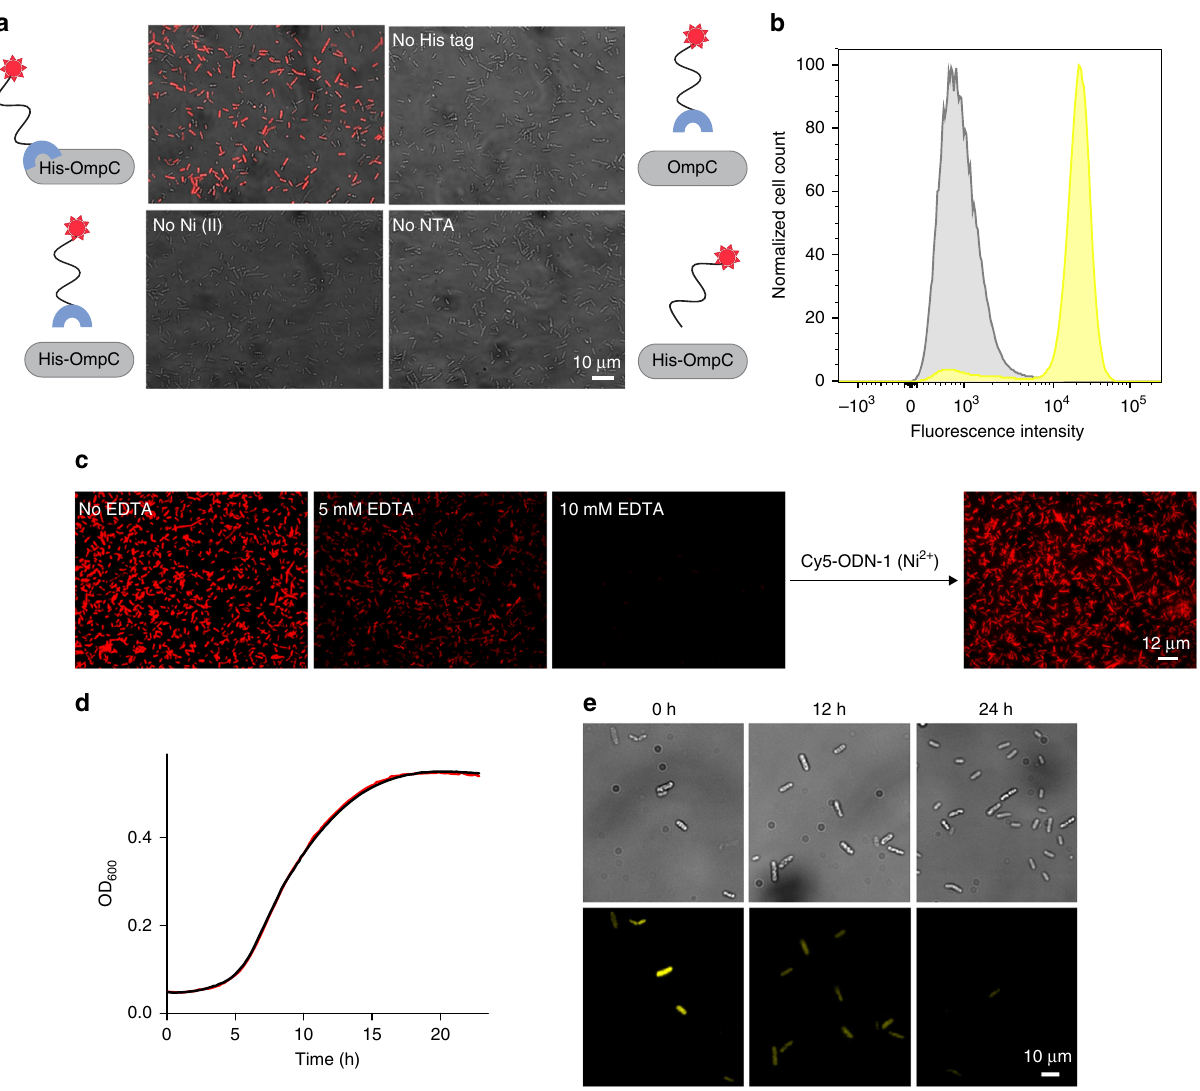
Fig. 2 Reversible, non-covalent modi fi cation of a bacterial membrane using ODN-based synthetic receptors. a Merged bright- fi eld and fl uorescence images of the following: (Top left) E. coli expressing His-OmpC incubated with 500 nM of Cy5-ODN-1 and Ni (II). (Top right) Bacteria lacking His-tag incubated with 500 nM of Cy5-ODN-1 and Ni (II). (Bottom left) His-tagged bacteria incubated with 500 nM of Cy5-ODN-1 in the absence of Ni (II). (Bottom right) His-tagged bacteria incubated with 500 nM of Cy5-ODN (that lacks the NTA group) and Ni (II). b Flow cytometry analysis of His-tagged bacteria (yellow) and bacteria lacking His-tag (gray) incubated with TAMRA-ODN-1. c Images of E. coli expressing His-OmpC decorated with Cy5-ODN-1 in the presence of increasing concentrations of EDTA (0, 5, and 10 mM) (left), and following the subsequent addition of Cy5-ODN-1 in the presence of Ni (II) (right). d Growth curve of E. coli expressing His-OmpC (black) and the growth of the same bacteria decorated with TAMRA-ODN-1 (red). e Bright- fi eld (top) and fl uorescence images (bottom) of bacteria decorated with TAMRA-ODN-1 monitored at 0, 12, and 24 h. Source data are available in the Source Data fi (Fig. 2a, top left) con fi rms the selectivity of ODN-1 toward the His-tag on the bacterial membrane. The selectivity and degree of labeling were further analyzed by fl ow cytometry (Fig. 2b), which revealed 1% (gray) and 90.9% (yellow) labeling of the bacteria